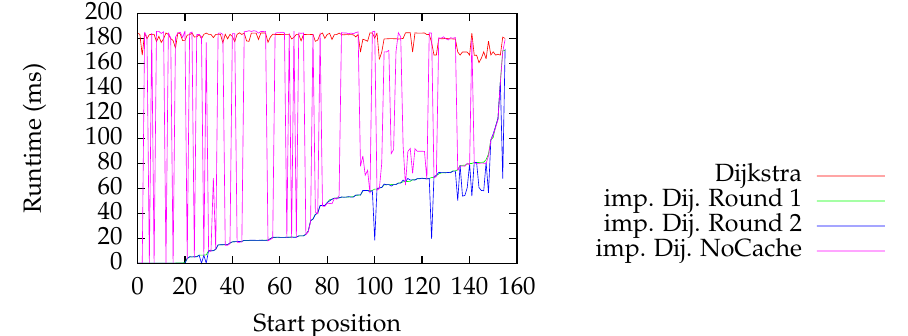
Figure 11. Random queries on the Munich dataset. The start vertices are enumerated by start positions (the x -axis in the plot), which are ranked ascendingly with respect to the time consumed by our algorithm in its first round. The curves Dijkstra measure the time for Dijkstra’s algorithm to find the shortest paths to all target vertices. The other curves with prefixes imp. Dij. denote our solution using Dijkstra’s algorithm. The implementation with suffix NoCache does not cache past queries, while Round 1 caches query vertices, and Round 2 makes use of the cache of Round 1